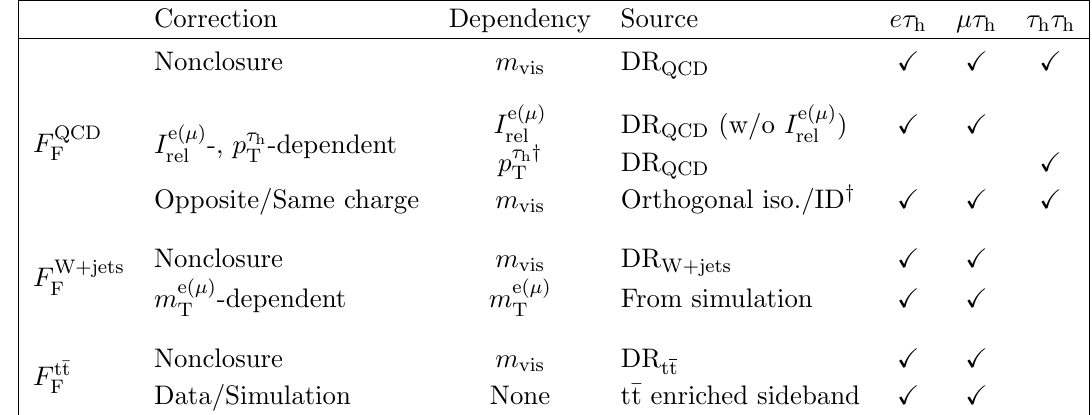
Table 4 . Corrections applied to the F QCD column the source is indicated from which the correction is derived. The dependency p (cid:28) h